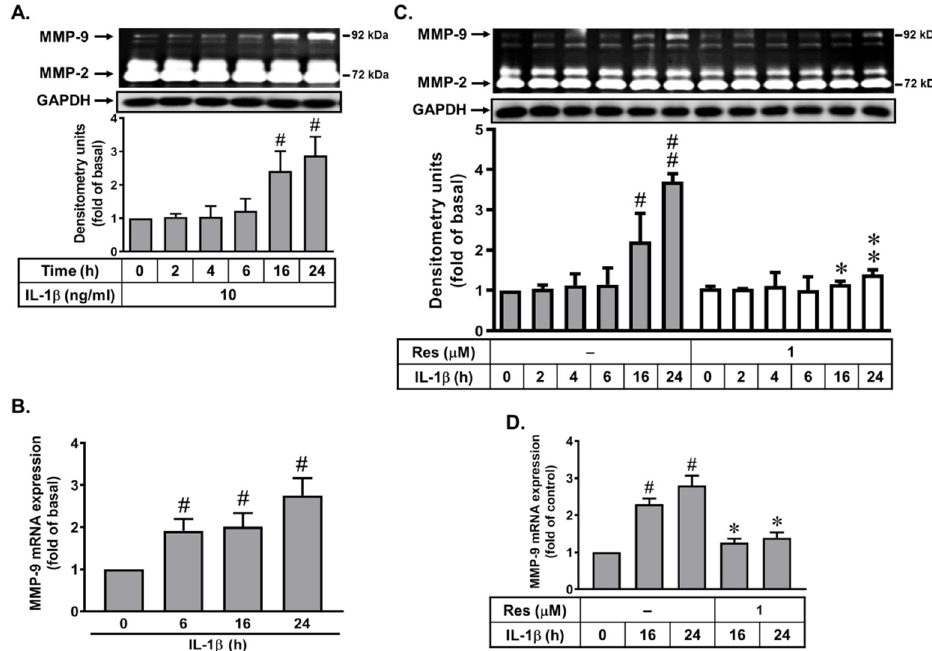
Figure 1. Effects of resveratrol on IL-1 β -induced MMP-9 expression in bEnd.3 cells, including protein and mRNA level. ( A , B ) Time dependence of IL-1 β increase of MMP-9 expression. The bEnd.3 cells were treated with 10 ng/mL IL-1 β for the indicated time intervals. ( C , D ) Cells were pretreated with resveratrol (Res, 1 μ M) for 1 h and then incubated with IL-1 β (10 ng/mL) for the indicated times. After treatment, the conditioned media, cell lysates, and total RNA were collected and analyzed by gelatin zymography (MMP2/9), Western blot (GAPDH, as an internal control), and RT-PCR ( MMP-9 and β -actin ), as described in Methods. The intensity of zymographic ( A , C ) and PCR product ( B , D ) bands were quantitated by scanning densitometry and expressed as fold of untreated control. Quantitative data were analyzed by one-way ANOVA, as described in Methods. Data are expressed as the mean ± SEM ( n = 3); # p < 0.05; ## p < 0.01, as compared with the untreated control; * p < 0.05; ** p < 0.01, as compared cells stimulated with IL-1 β only ( C, D ). The image represents one of three individual experiments.